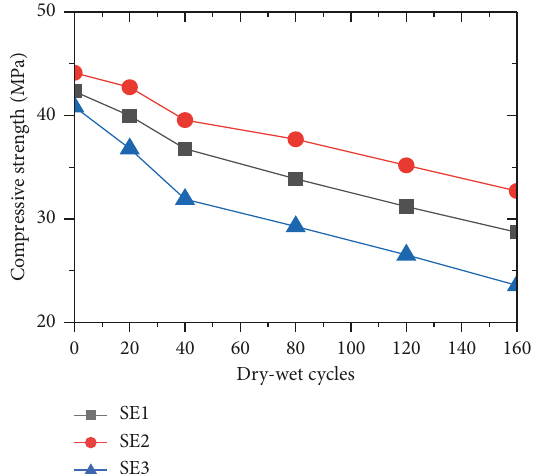
Figure 7: The relationship between compressive strength and dry- wet cycles.